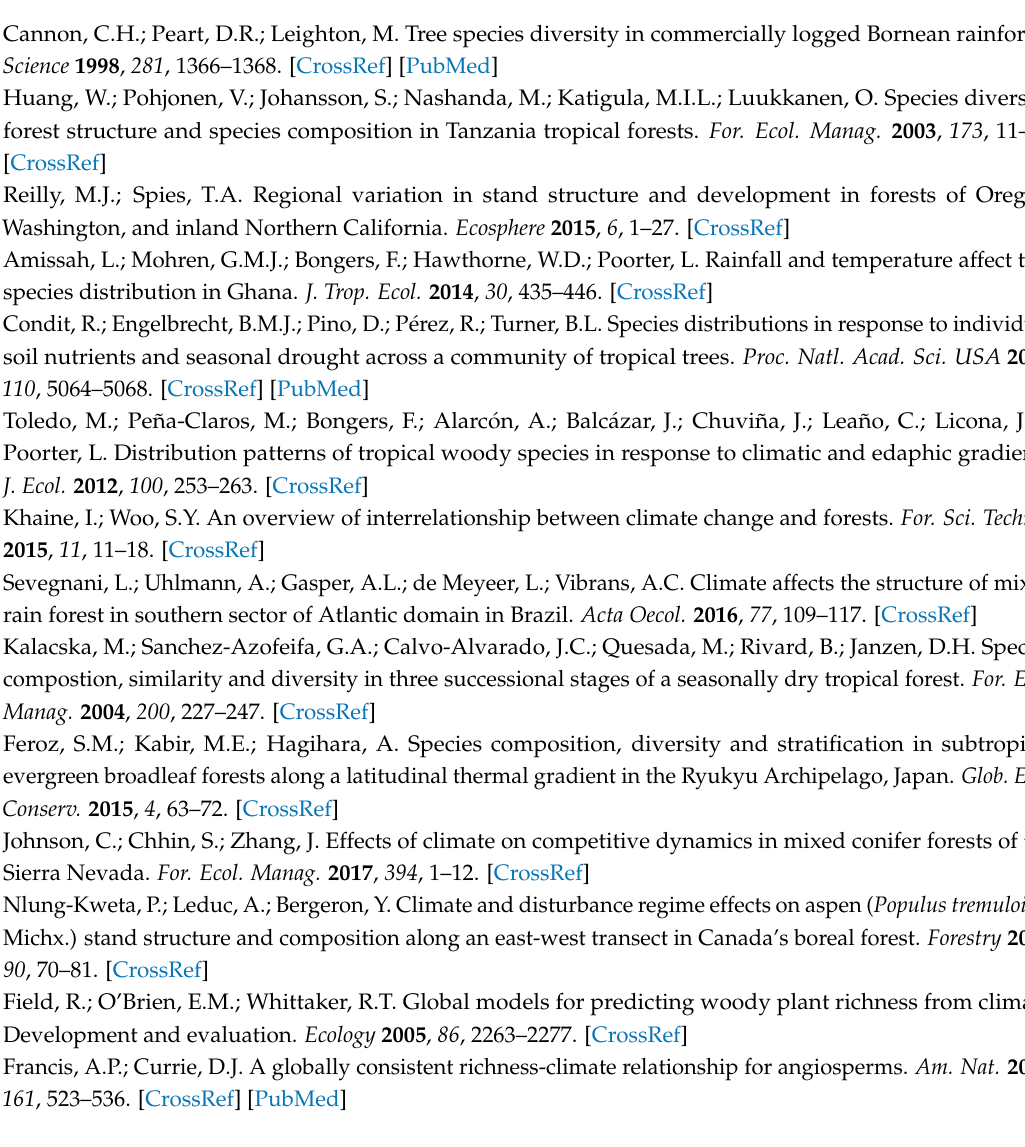
Table S1: Important value index, relative density, relative frequency and relative coverage of 20 dominant species of forests at study site 1, Table S2: Important value index, relative density, relative frequency and relative coverage of 20 dominant species of forests at study site 2, Table S3: Important value index, relative density, relative frequency and relative coverage of 20 dominant species of forests at study site 3, Table S4: Important value index, relative density, relative frequency and relative coverage of 20 dominant species of forests at study site 4, Table S5: Important value index, relative density, relative frequency and relative coverage of 20 dominant species of forests at study site 5, Table S6: Tree density and basal area of five study sites, Table S7: Species name and their abbreviations of five study